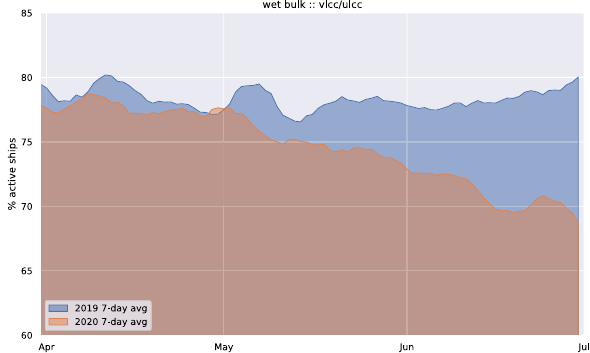
Figure 4. Daily active and idle ships in 2019 (in blue) and 2020 (in orange) of the supertankers, VLCC and ULCC. The two area charts are overlaid in transparency to highlight trend differences. It is evident a decrease (increase) of active (idle) ships for this category from April, 2020, not present in 2019. This is confirming the use of a significant subset of supertankers as oil storage 37